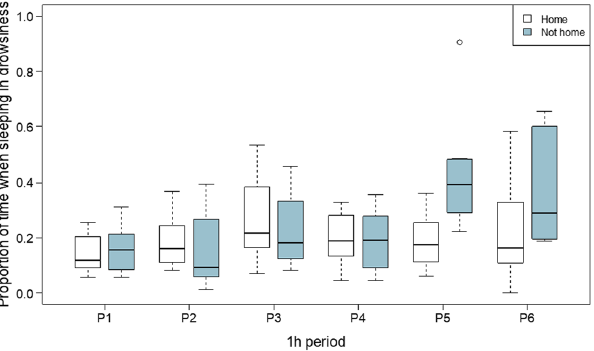
Figure 1. Location-specific effects of period on proportion of time spent in drowsiness: Period had location- specific effects on proportion of time spent in drowsiness, such that the difference between time in drowsiness during the fifth period was greatest (and positive) when measured not at home. Note. The figure illustrates data from nighttime recordings